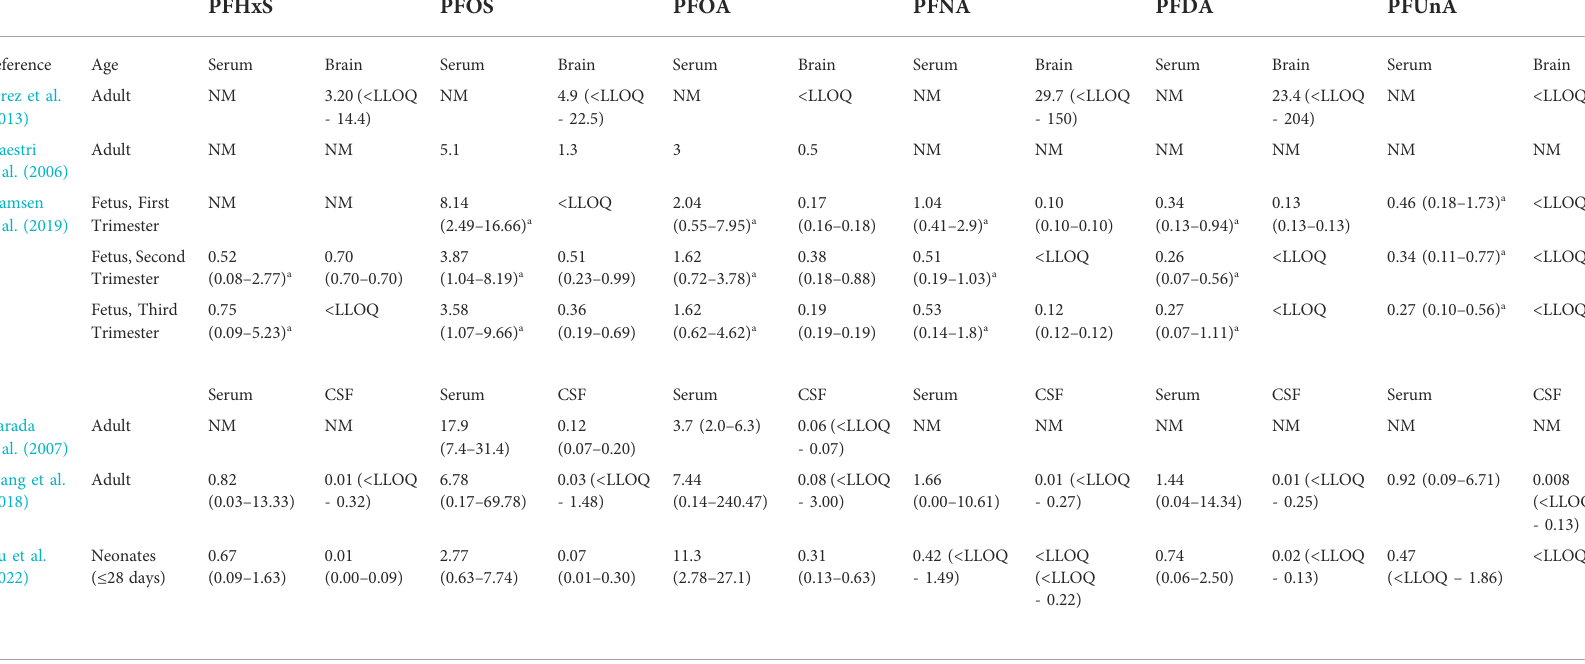
TABLE 1 Mean (range) concentrations of per- and poly fl uorinated substances (PFAS) in human brain and sera samples. PFHxS Reference Perez et al.